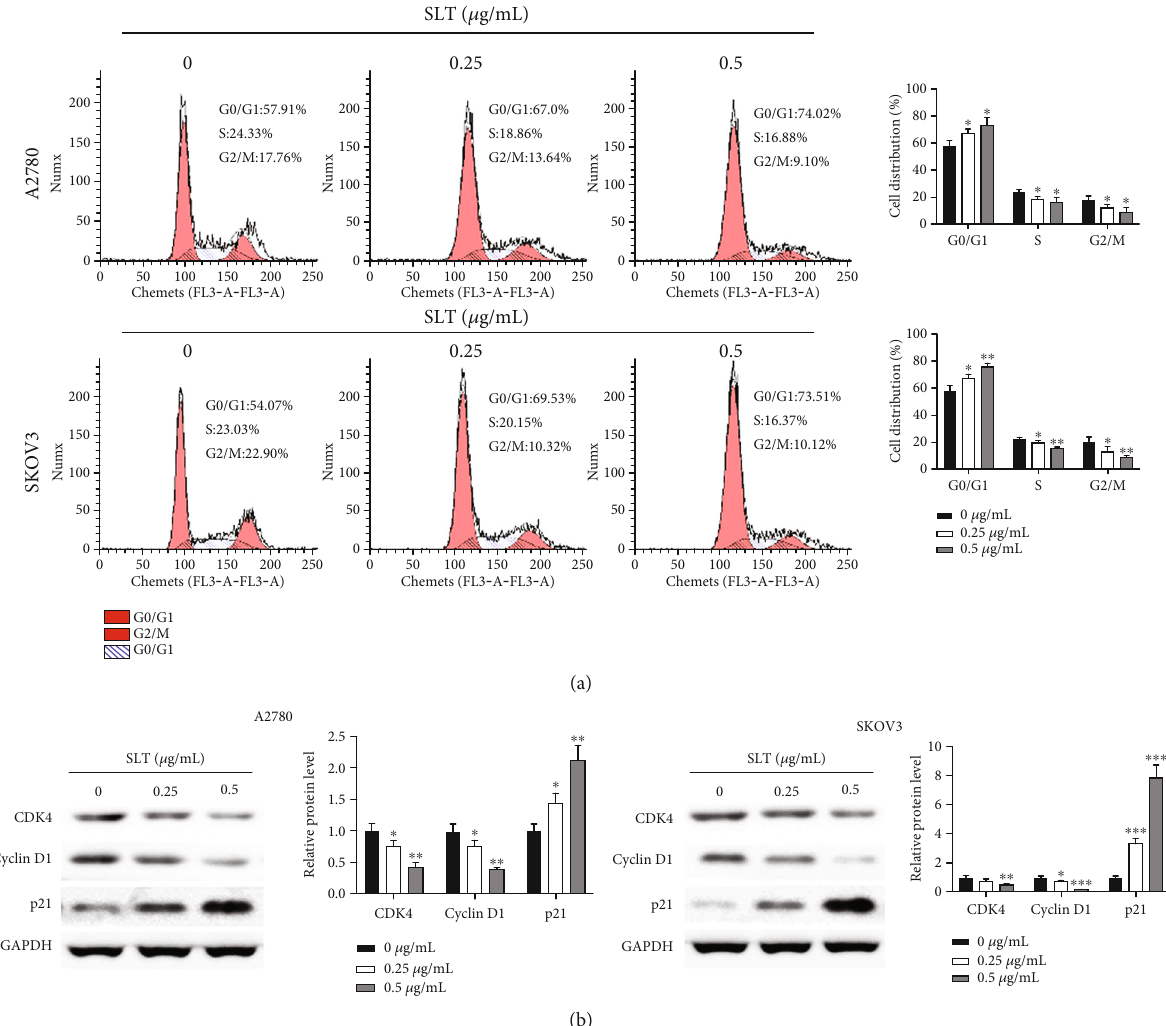
Figure 2: The e ff ects of SLT on cell cycle of ovarian cancer. (a) The e ff ects of SLT on cell cycle distribution of A2780 and SKOV3 cells were analyzed via fl ow cytometry. (b) The e ff ects of SLT on the expression levels of cell cycle-related proteins in A2780 and SKOV3 cells were evaluated via western blot assay. The values were displayed as the mean ± SD . Representative results from three independent experiments were shown ( ∗ P < 0 : 05 , ∗∗ P < 0 : 01 , and ∗∗∗ P < 0 : 001 , compared with the control